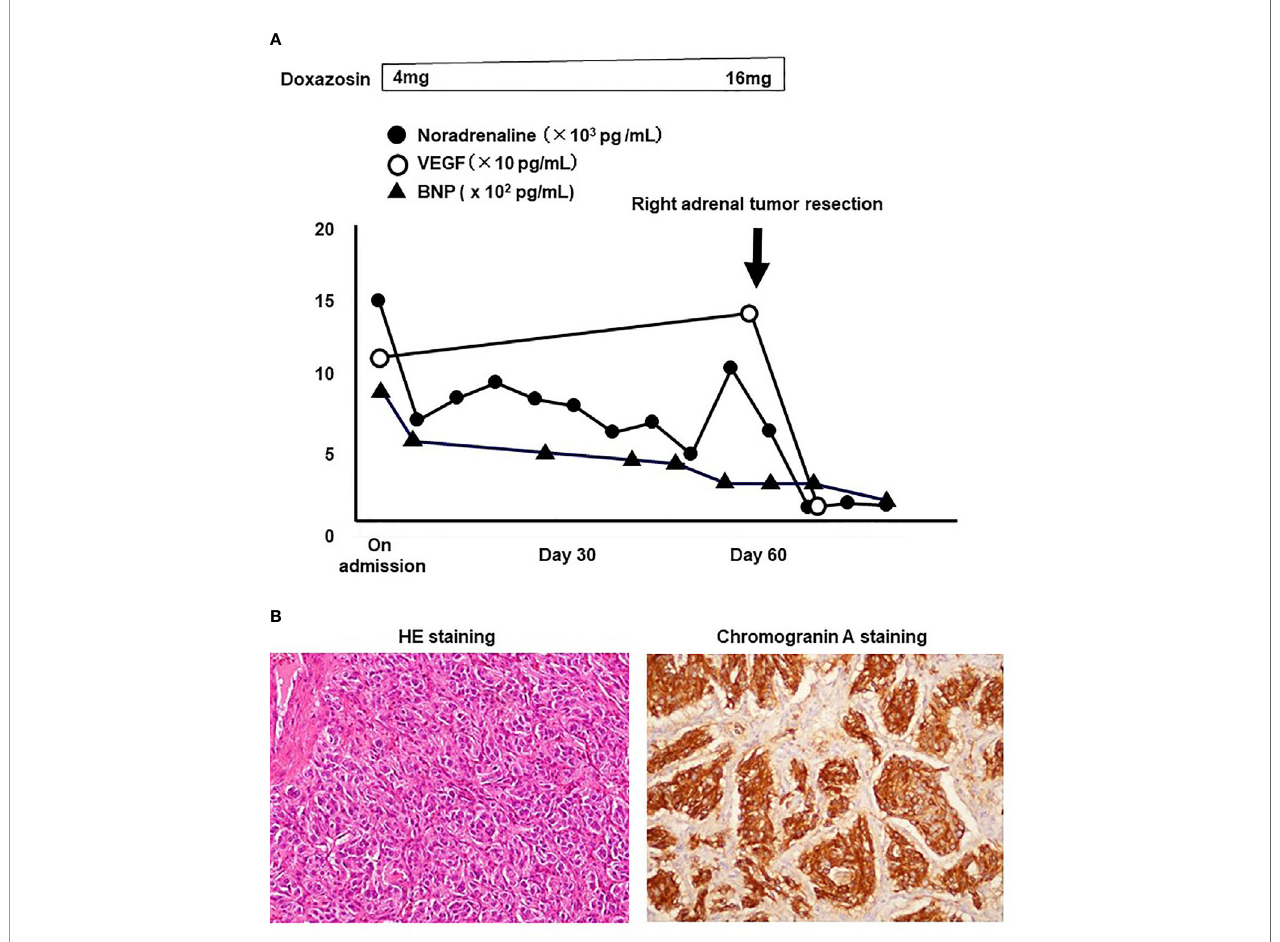
FIGURE 2 | (A) Time course of noradrenaline, vascular endothelial growth factor (VEGF), and brain natriuretic peptide (BNP). Noradrenaline and VEGF levels were drastically decreased after right adrenal tumor resection, and BNP level was also gradually decreased before the operation. (B) In HE staining of the resected left hepatic lobe, there was small solid alveolar structure with a lot of relatively small cells and spindle-shaped nuclei were observed in some of such cells (left panel). In addition, in chromogranin A staining, many chromogranin A-producing cells were observed (right